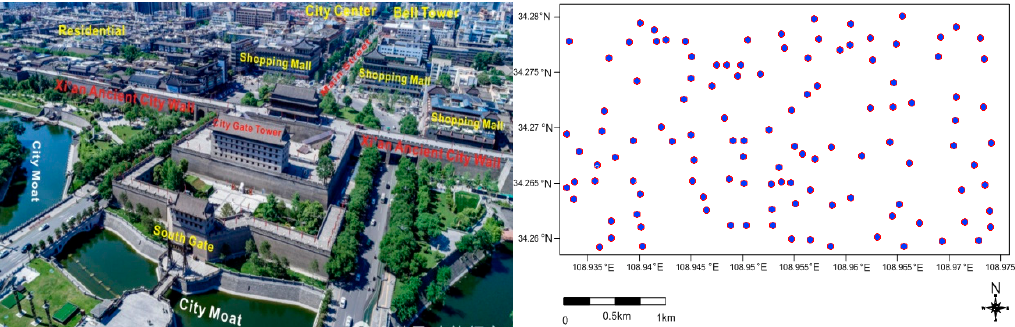
Figure 1. The distribution map of dust sample sites. (City picture source from Qi e hao Da lv xing